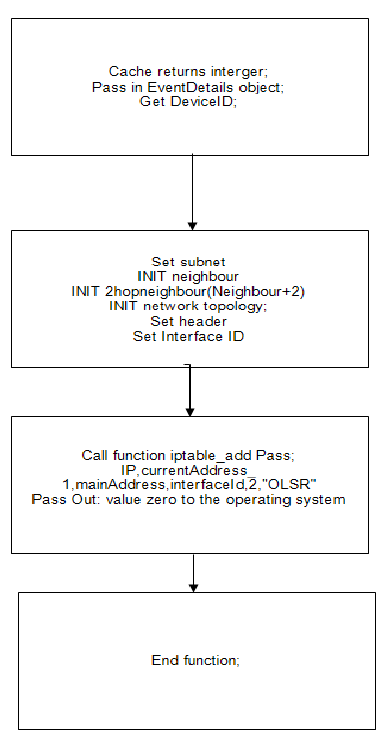
Figure 6. Malicious route added to the cache.